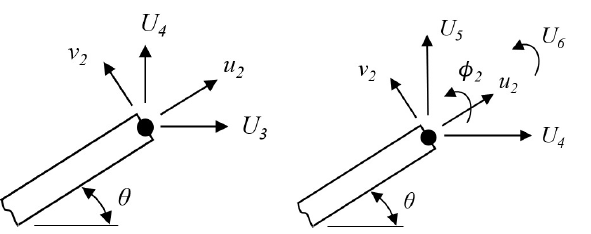
Figure 1. Global displacement in a single node for elementary and Love rods on LHS and Mindlin- Hermann rod on RHS.